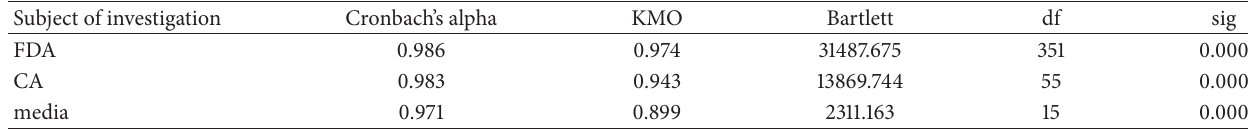
Table 3: Test of reliability and validity.